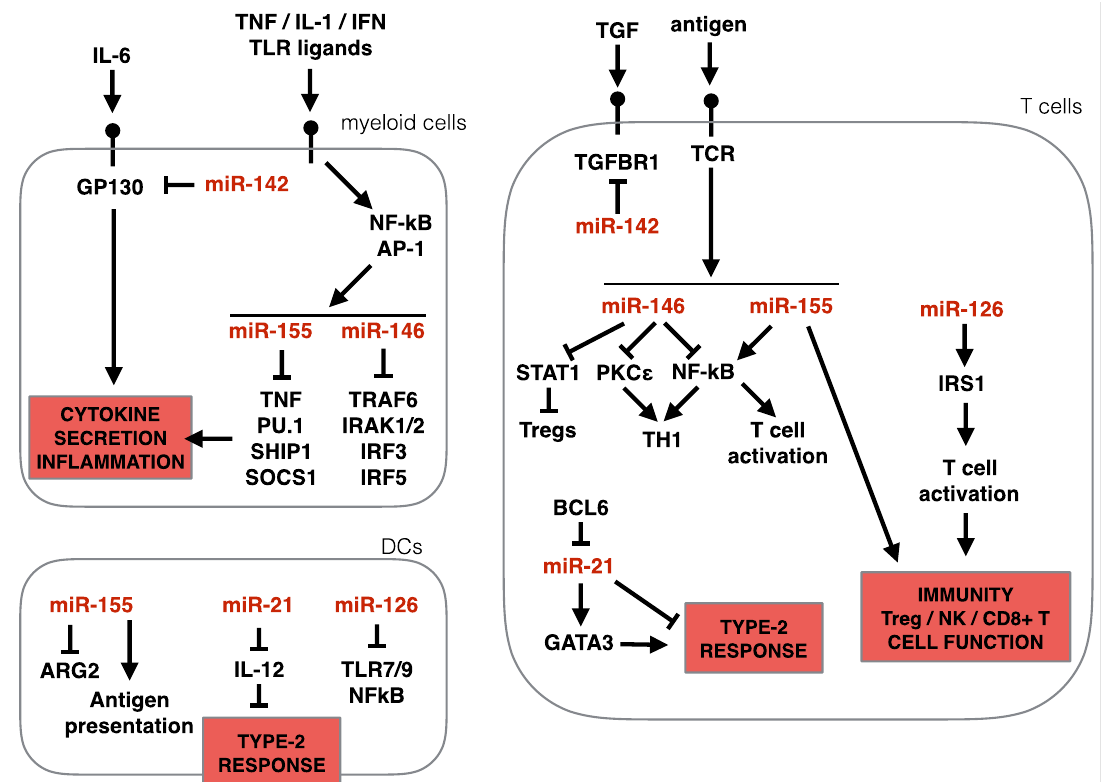
Figure 6. Type-2 related miRNAs in the hematopoietic compartment. Blood cells that play a significant role in the type-2 immunity are controlled by type-2 related miRNAs.